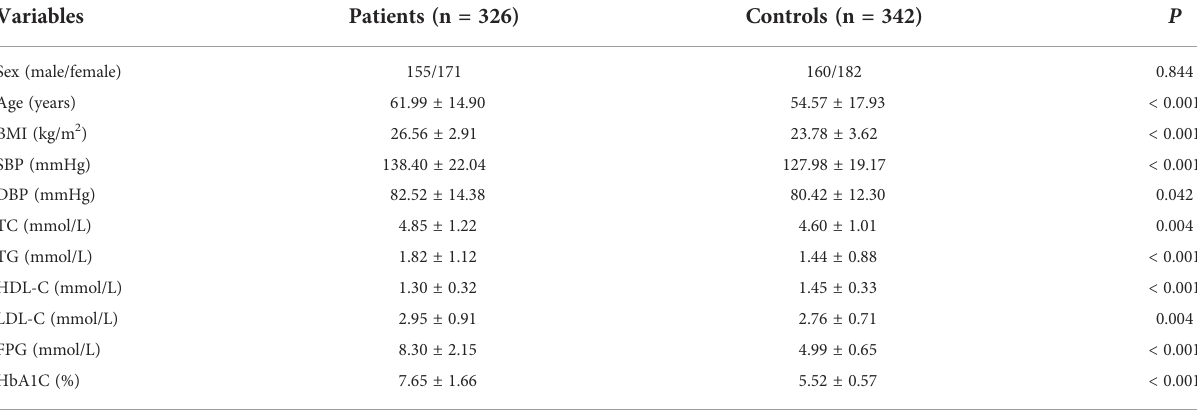
TABLE 1 Clinical characteristics and laboratory data of study participants. Variables